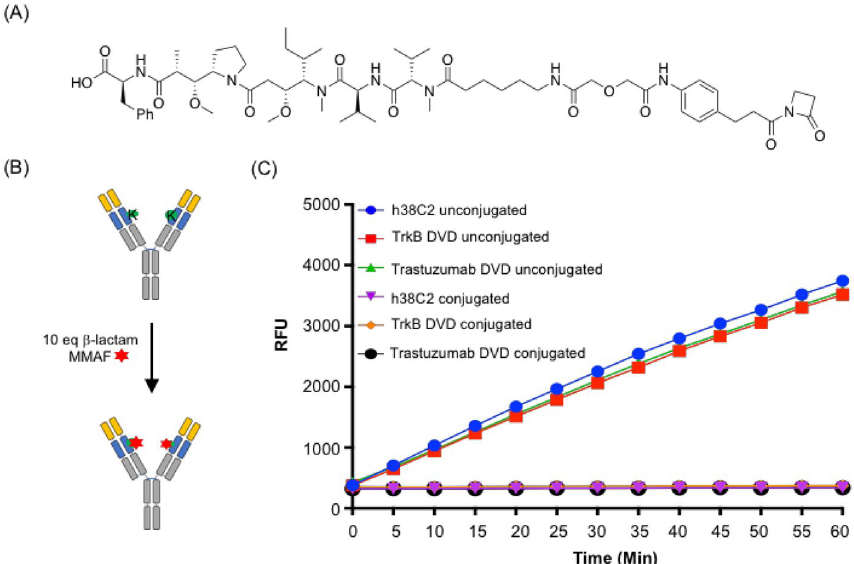
Figure 3. Generation of anti-TrkB DVD-ADCs ( A ) A β-lactam functionalized MMAF compound with a non-cleavable linker was used for ADC assembly. ( B ) The DVD-ADC was prepared by incubating the anti-TrkB DVD with 10 eq of β-lactam MMAF (red star) in PBS for 4 h at room temperature. The reactive Lys99 residue (K) is shown in green. ( C ) As Lys99 reacts with the β-lactam moiety to form an amide bond, DVD is no longer catalytically active, thus confirming complete conjugation. The signal is reported in relative fluorescent units (RFU; mean ± SD of triplicates). Abbreviation: dual variable domain (DVD), relative fluorescence units